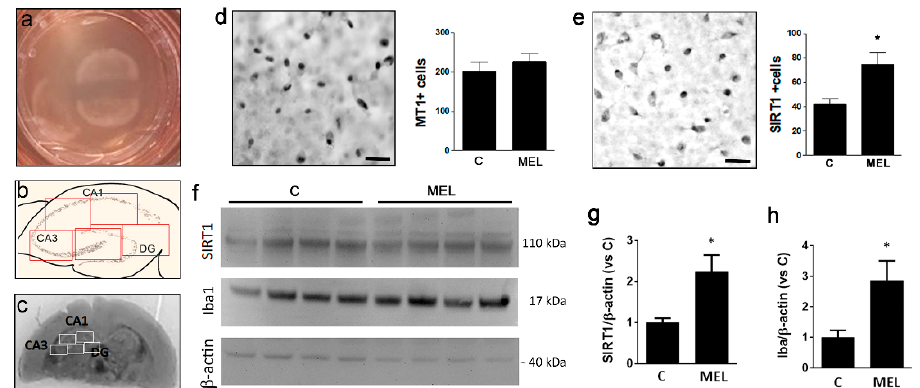
Figure 1. Overview of organotypic brain cultures (OCs). In ( a ), OCs (150 µ m) prepared from 8–10 day postnatal wild-type mice after culturing for 2 weeks on an insert at the liquid/air interface. The two hippocampal formations (HC) were visible in each slice ( c ). Five areas, indicated by the boxes in ( b , c ), were imaged to cover the entire HC and analyzed for the number of melatonin receptor 1 (MT1)- ( d ) or SIRT1-positive ( e ) cells in control condition (C) or after exposure to melatonin (MEL) for 14 days. The protein levels of SIRT1 ( f , g ) and Iba1 ( f , h ) were detected by Western blot. Representative images are shown. Scale bars ( d , e ) = 100 μ m. Data are the mean ± SEM of at least 3 experiments. * p < 0.05 vs. C by Student’s t -test for significance.